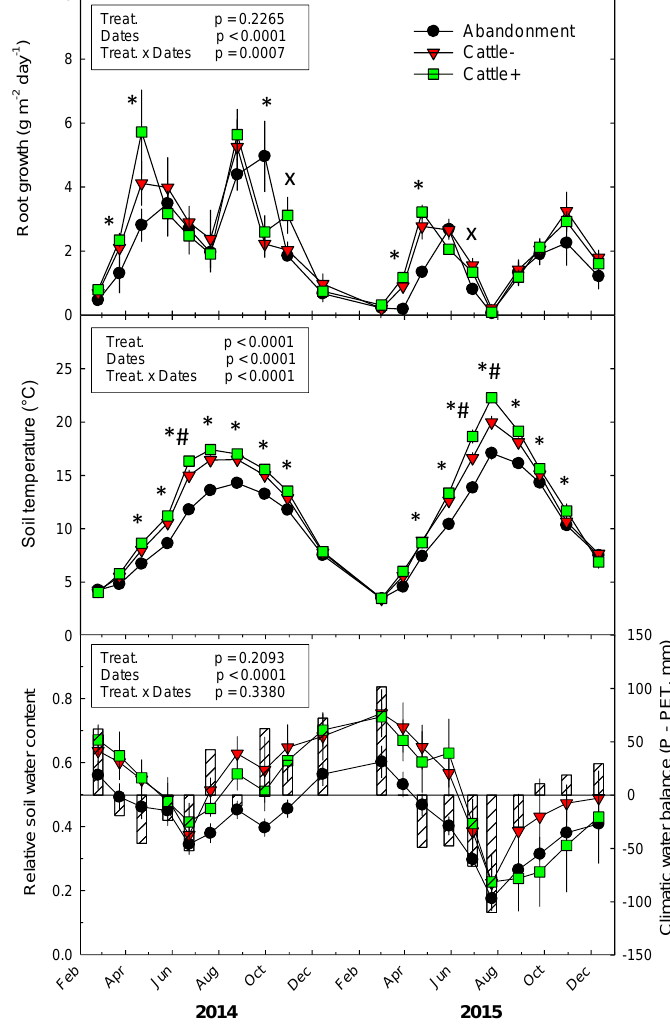
to significant differences (Abandonment < Cattle- <